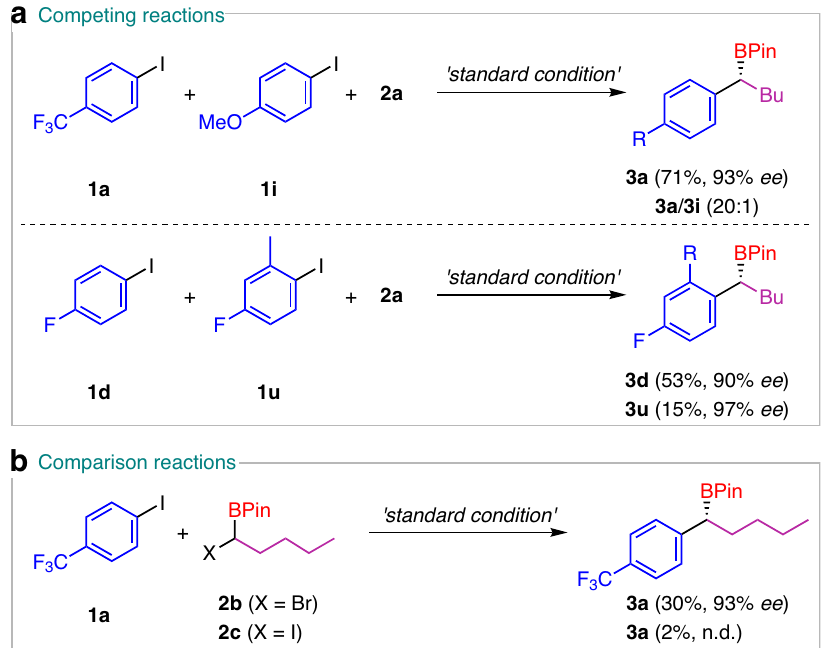
Fig. 3 Competing and comparison reactions. a The reaction with aryl halides with different properties. b Test on the α -bromo- or α